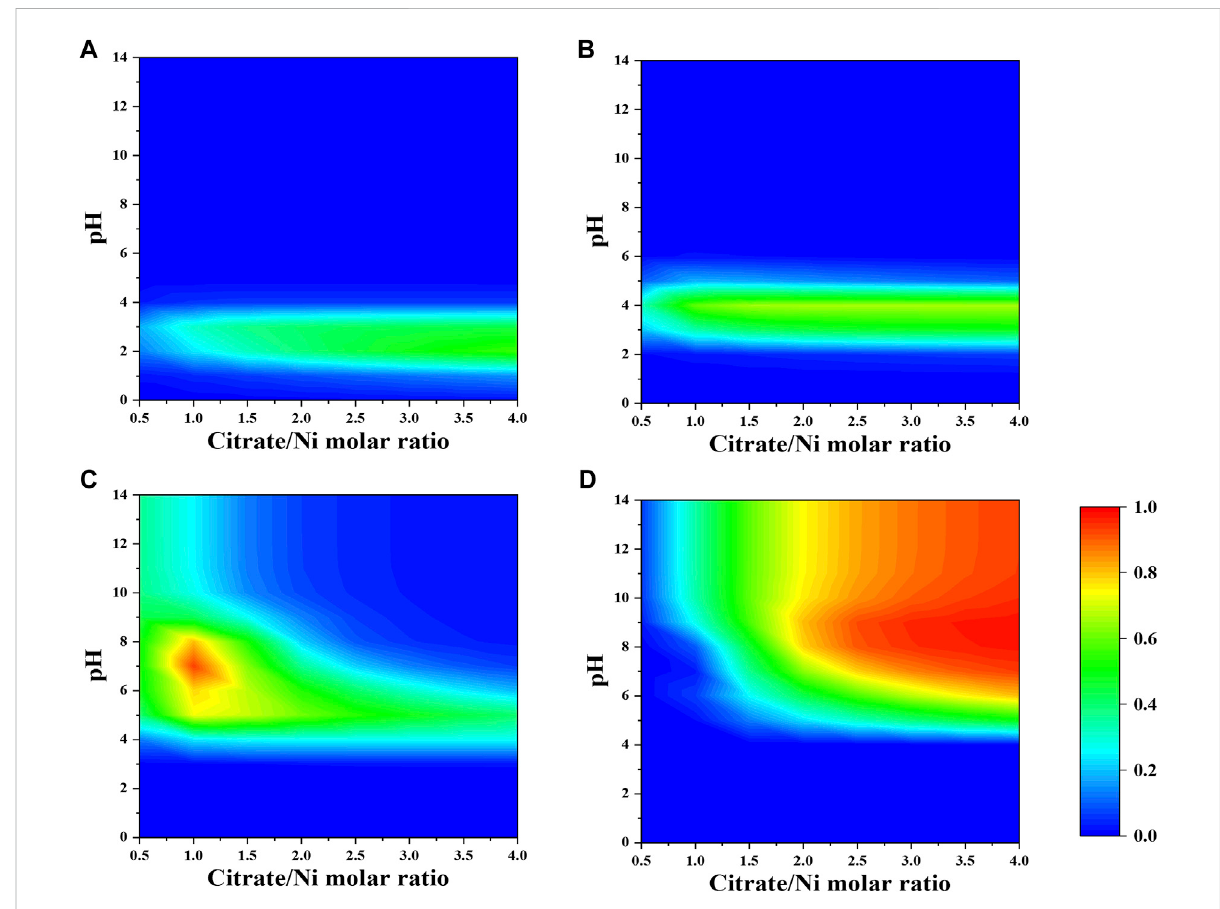
FIGURE 4 Fraction of nickel-citrate complexes (A) NiH 2 Cit + , (B) NiHCit, (C) NiCit − , and (D) NiCit 2 4- as a function of citrate-to-nickel molar ratio and pH in the presence of NH